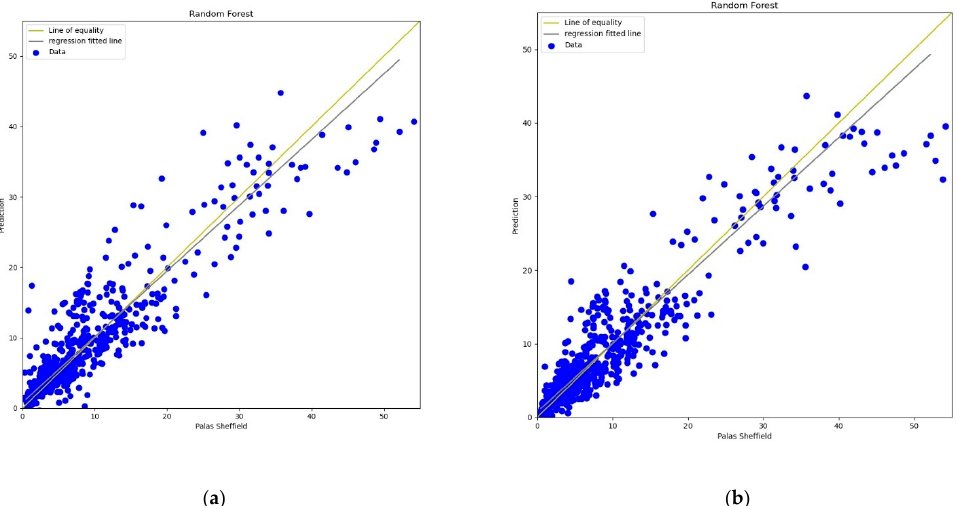
Figure 18. ( a ) RF calibration scatter plot for PM 2.5 with the line of equality, regression fitted line, and the calibrated data using AH ; ( b ) RF calibration scatter plot for PM 2.5 with the line of equality, regression fitted line, and the calibrated data using RH .